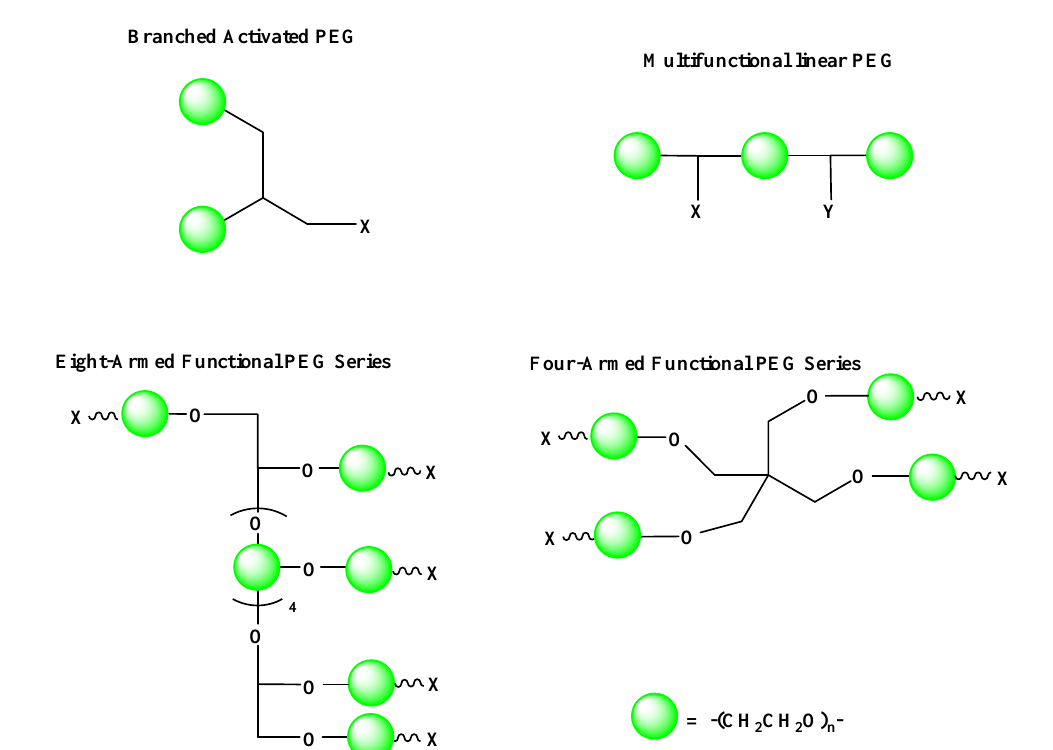
1. Schematic composition of branched, multi-armed and multifunctional poly(ethylene glycol) (PEG)-based